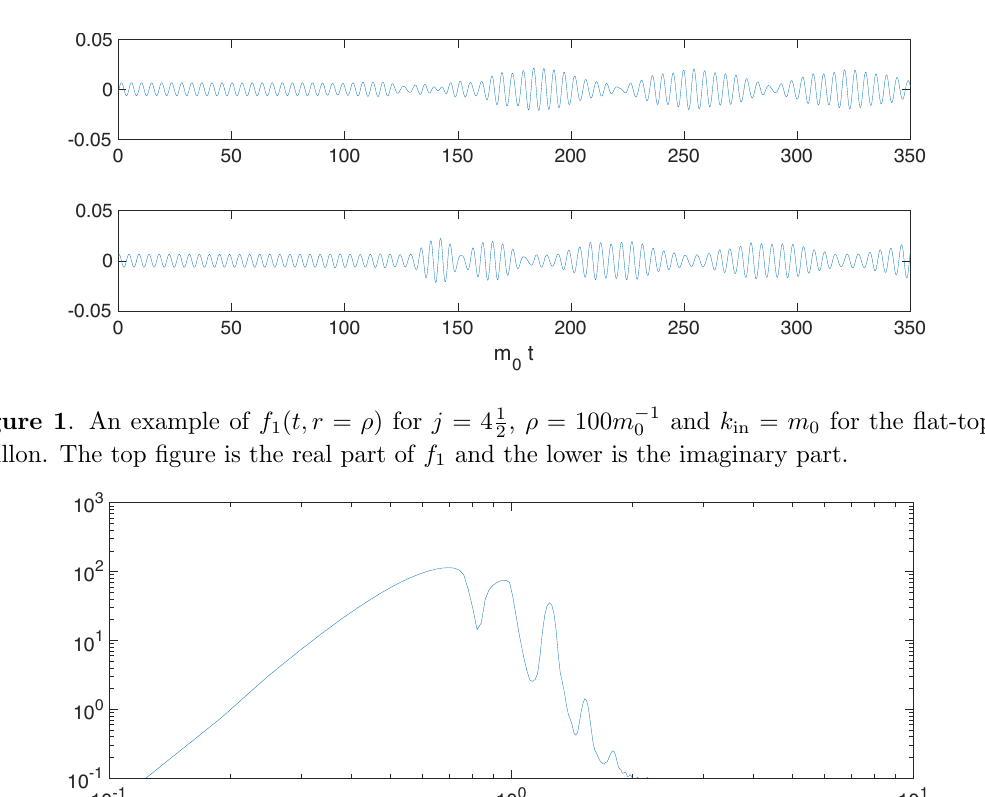
for the (cid:13)at-topped oscillon example in the (cid:1) (cid:28)